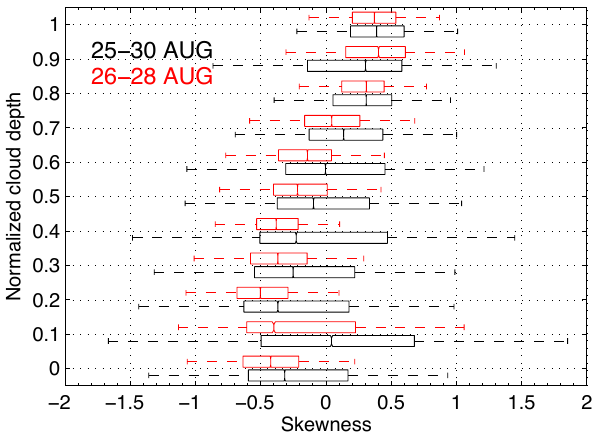
Fig. 4. In-cloud vertical velocity skewness ( S w ) distribution as a Figure 4. In-cloud vertical velocity skewness (S w ) distribution as a function of function of normalized in-cloud height (0 is cloud base and 1 is cloud top; see Eq. 1). Rectangles represent the 25th–75th percentile normalized in-cloud height (0 = cloud base, 1 = cloud top, see Eq. (1)). Rectangles range, vertical lines within the rectangles represent median values represent the 25 th -75 th percentile range, vertical lines within the rectangles represent and the dashed lines indicate the 5th–95th percentiles. Data for the median values and the dashed lines indicate the 5 th -95 th percentiles. Data for the week week 25–30 August are in black, and for a shorter period, 26–28 25th-30th August are in black, and for a shorter period 26th-28th August in red. August, in